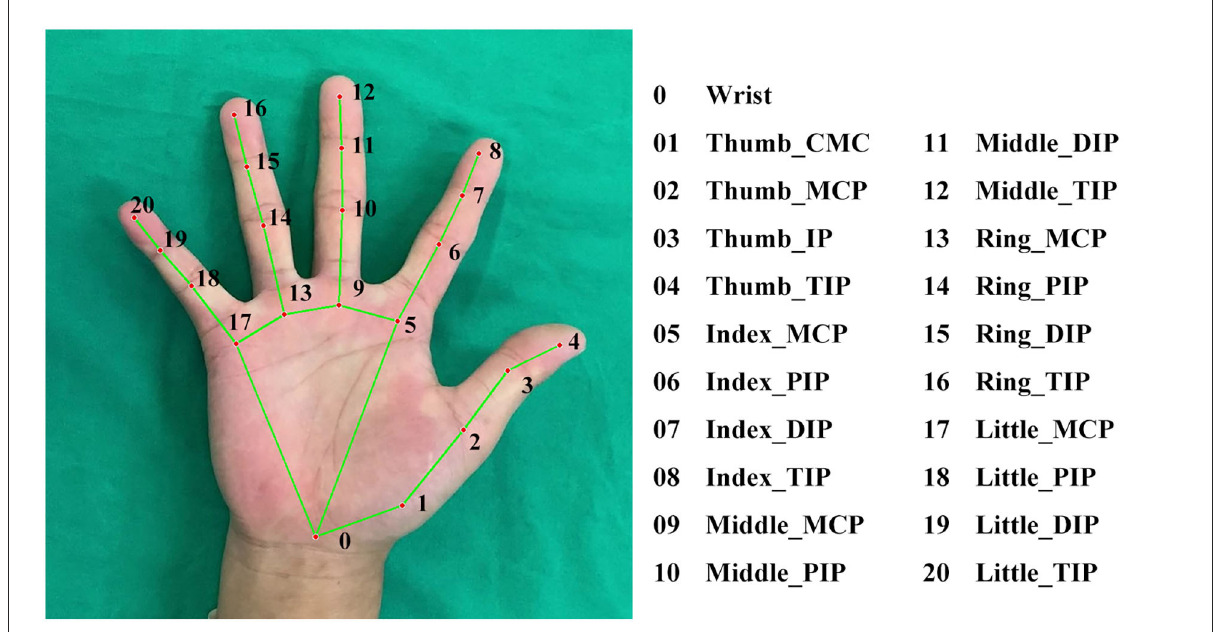
FIGURE3 The 21 landmarks of the skeleton model of MediaPipe